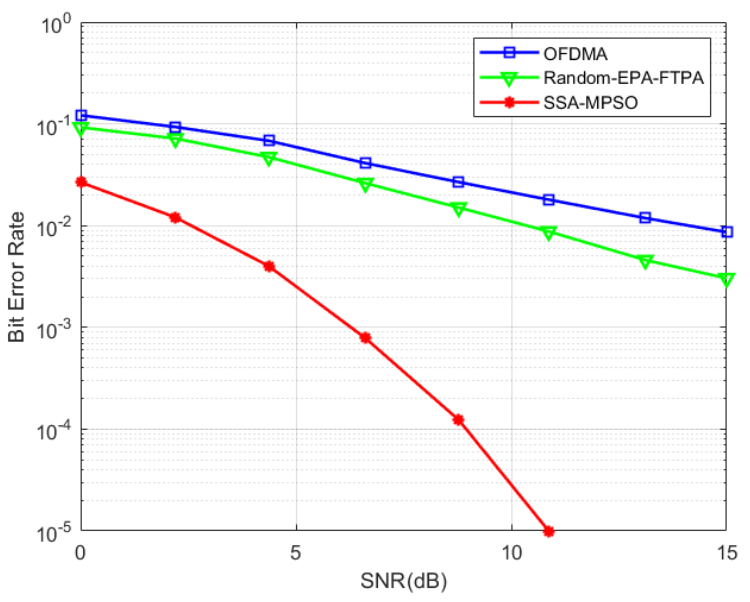
Figure 8. Bit error rate versus